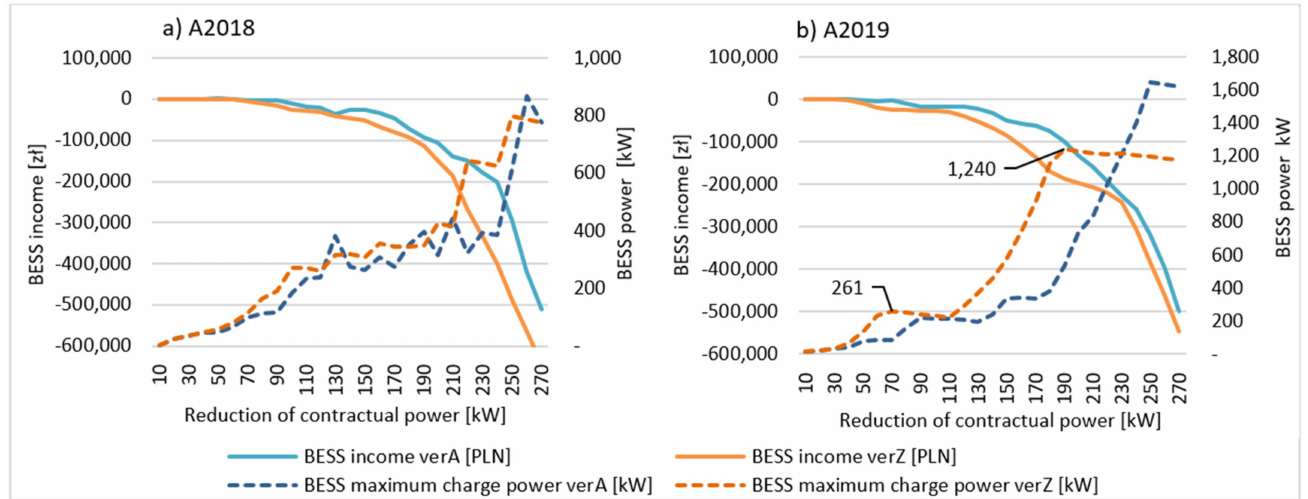
Figure 6. BESS income and BESS charging power as a function of the contractual power for enterprise. ( a ) A2018 and ( b )